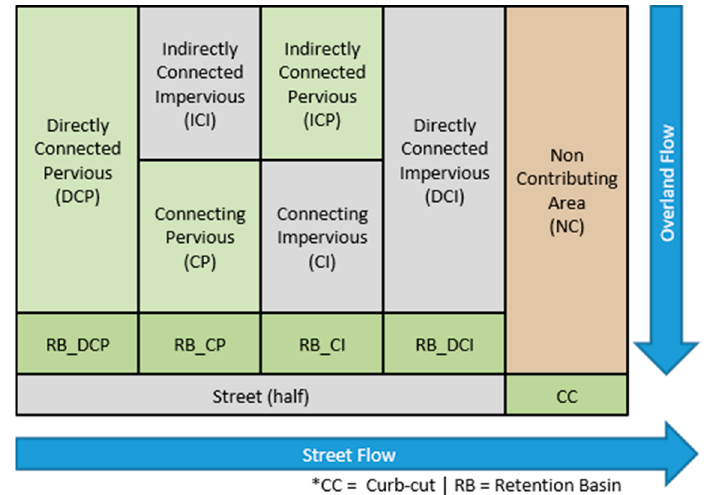
Figure 1. The KINEROS2 modeling element provides up to 13 modeling subcomponents that can be used to represent a single parcel.